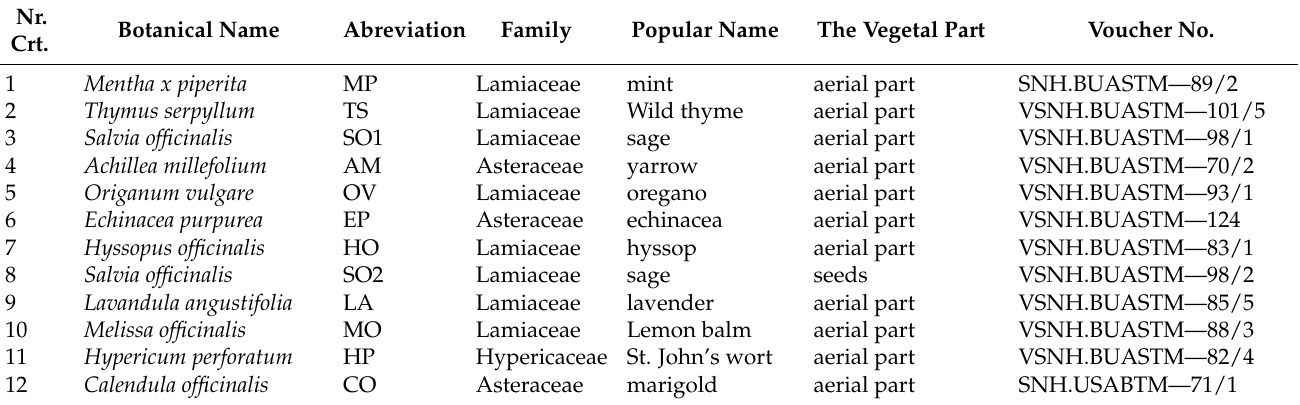
Table 1. The characteristics of studied medicinal